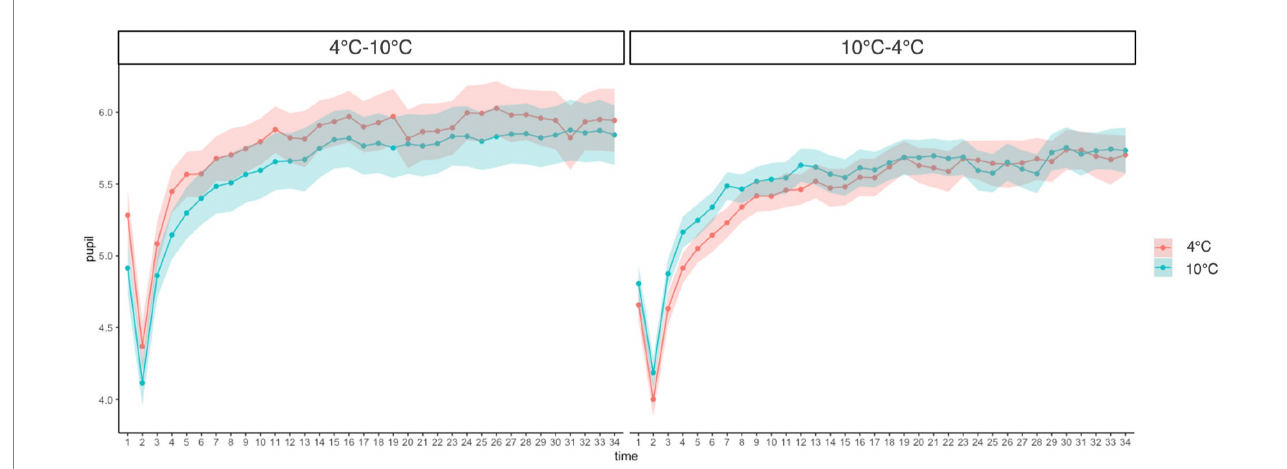
FIGURE 3 Change of pupillary response at different time points and temperatures compared between groups. Error bars represent standard errors of the mean.